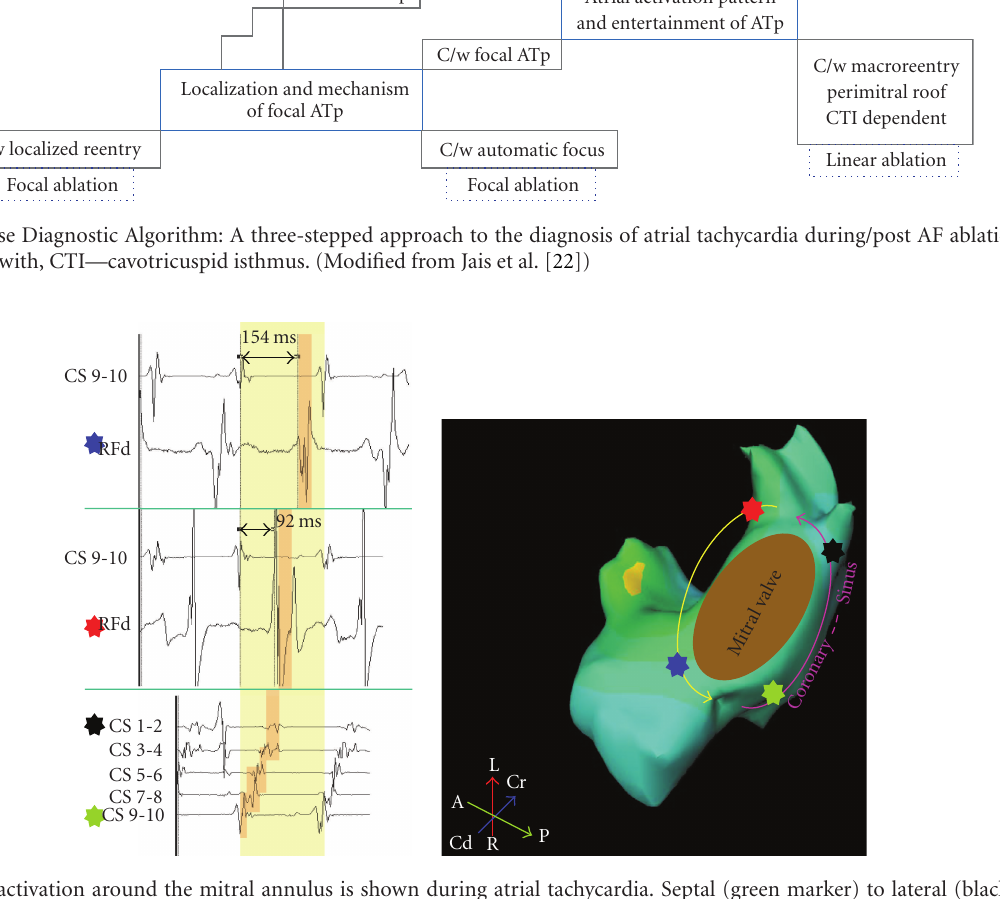
Figure 3: Atrial activation around the mitral annulus is shown during atrial tachycardia. Septal (green marker) to lateral (black marker) atrial activation pattern on decapolar coronary sinus (CS) catheter is demonstrated. Electrical activity recorded on mapping catheter (RF) in reference to proximal CS dipole 9-10 is demonstrated from two di ff erent sites (red and blue markers). Mapping catheter positioned at anterolateral mitral annulus (red marker) is activated 92 ms after proximal CS. Mapping catheter positioned at anteroseptal mitral annulus (blue marker) is activated 154 ms after proximal CS. Thus, during tachycardia, atrial activation proceeds laterally from the septum in the posterior left atrium and septally from the lateral aspect of anterior left atrium. This pattern conforms to that of perimitral flutter. Activation pattern around the mitral annulus comprises of the entire cycle length of this flutter (orange pillars march through yellow background which represents one cycle